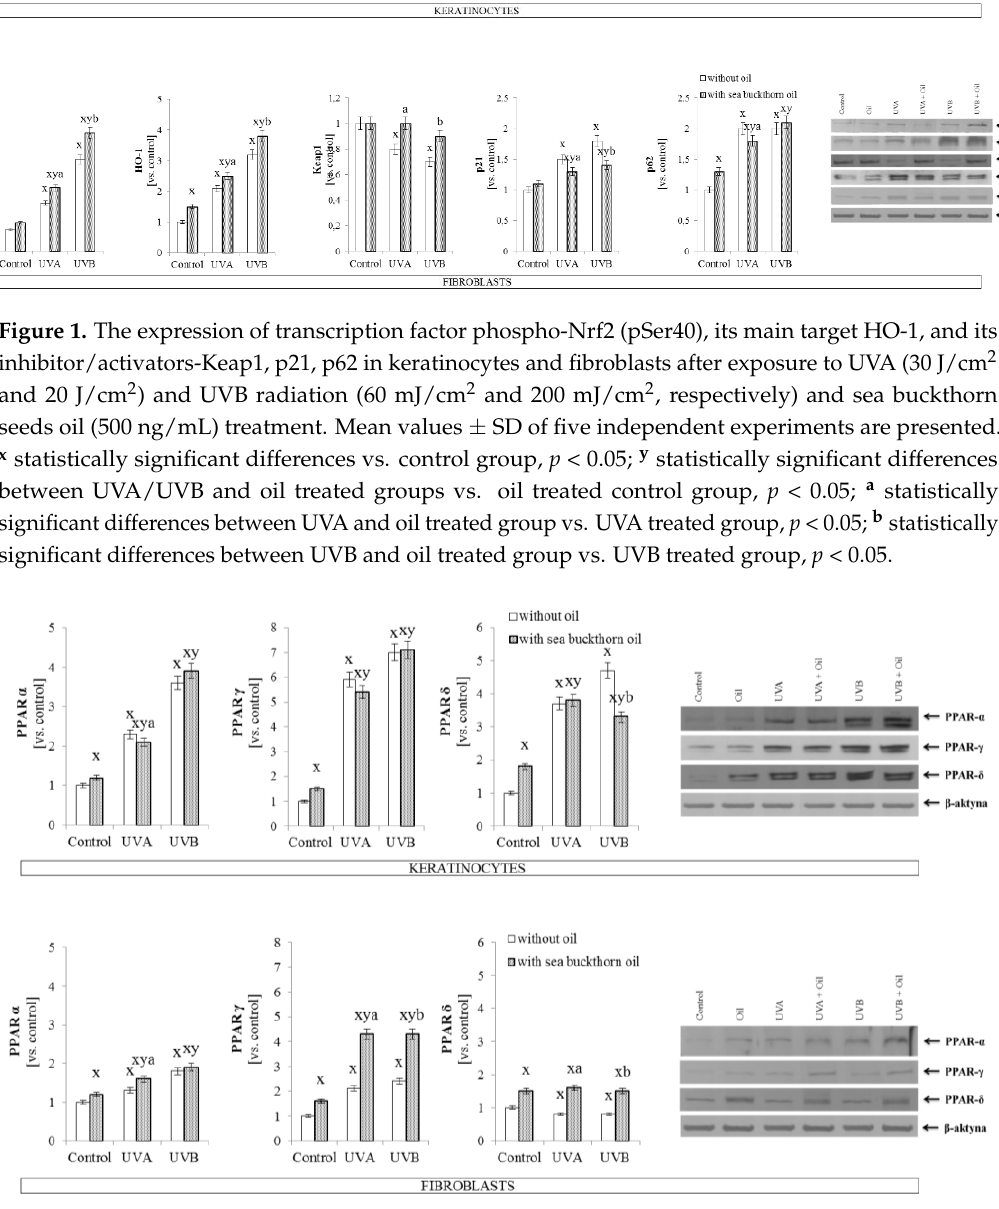
Figure 2. The expression of peroxisome proliferator-activated receptors (PPAR α , γ , and δ ) in keratinocytes and fibroblasts after exposure to UVA (30 J/cm 2 and 20 J/cm 2 ) and UVB radiation (60 mJ/cm 2 and 200 mJ/cm 2 , respectively) and sea buckthorn seeds oil (500 ng/mL) treatment. Mean values ± SD of five independent experiments are presented. x statistically significant differences vs. control group, p < 0.05; y statistically significant differences between UVA/UVB and oil treated groups vs. oil treated control group, p < 0.05; a statistically significant differences between UVA and oil treated group vs. UVA treated group, p < 0.05; b statistically significant differences between UVB and oil treated group vs. UVB treated group, p < 0.05.